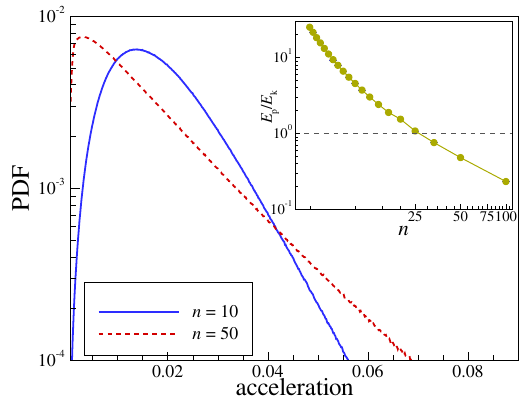
Figure 6. Probability distribution functions (PDF) of the particle accelerations in IPL melts for two different exponents: n = 10 (blue solid curve) and n = 50 (red dashed curve). The inset shows the ratio of the potential to kinetic energies stored in the system of interacting particles. The ratio drops below unity at  n 30 , which is close to the estimated failure of the QCA. Note that for n > 30 the IPL melts are strongly correlated, but not strongly